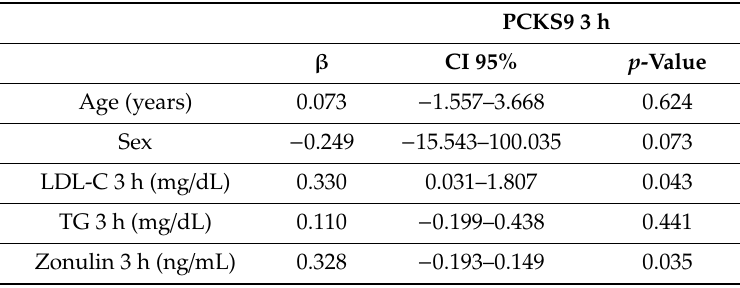
Table 4. Multiple linear regression analysis for PCSK9 3